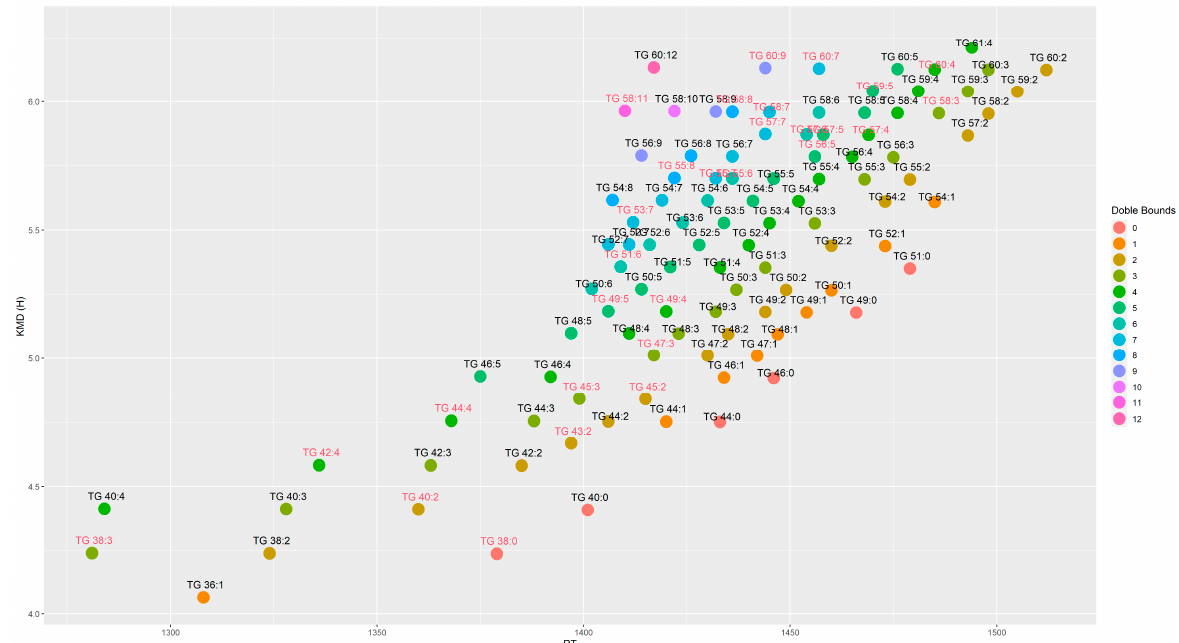
Figure 2. Kendricks Mass Defect calculated by the hydrogen base for triacylglycerols tentatively identified by the lipidomics approach. Metabolites were colored by doble bounds. Compound names without MS/MS experiments are colored in red.